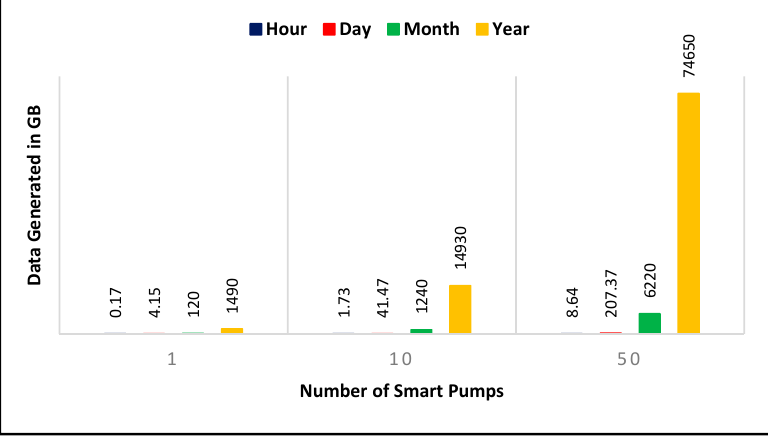
Figure 7. Data generation volume per-unit time for different number of pumps.